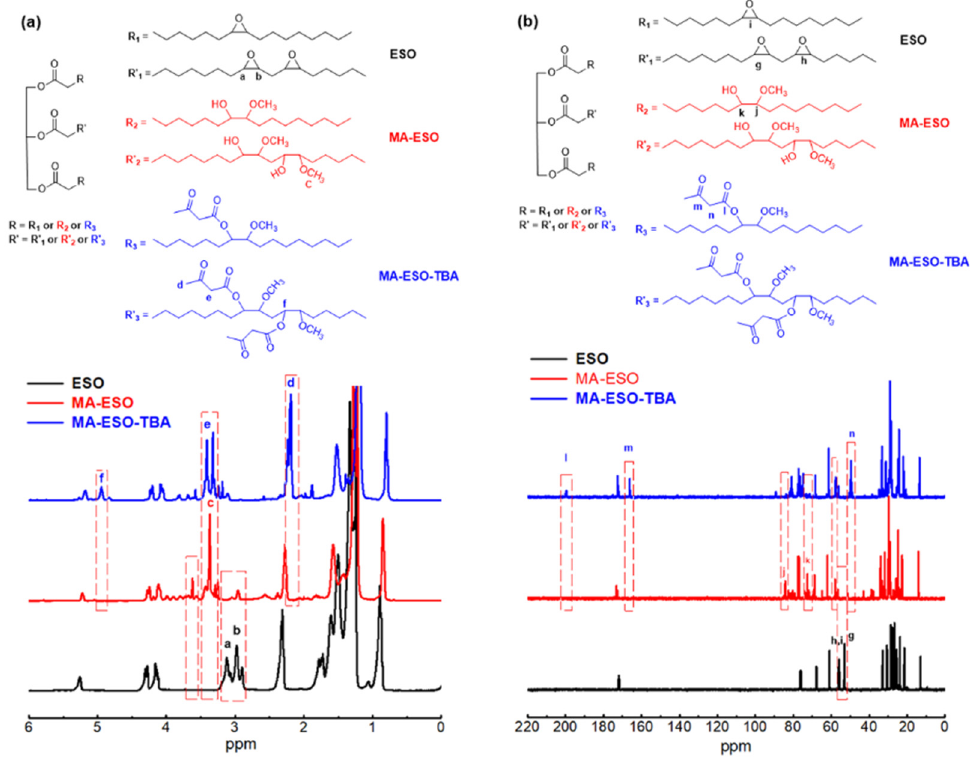
Figure 1. NMR spectra of acetoacetylated soybean oil: ( a ) 1 H NMR spectra and ( b ) 13 C NMR spectra.